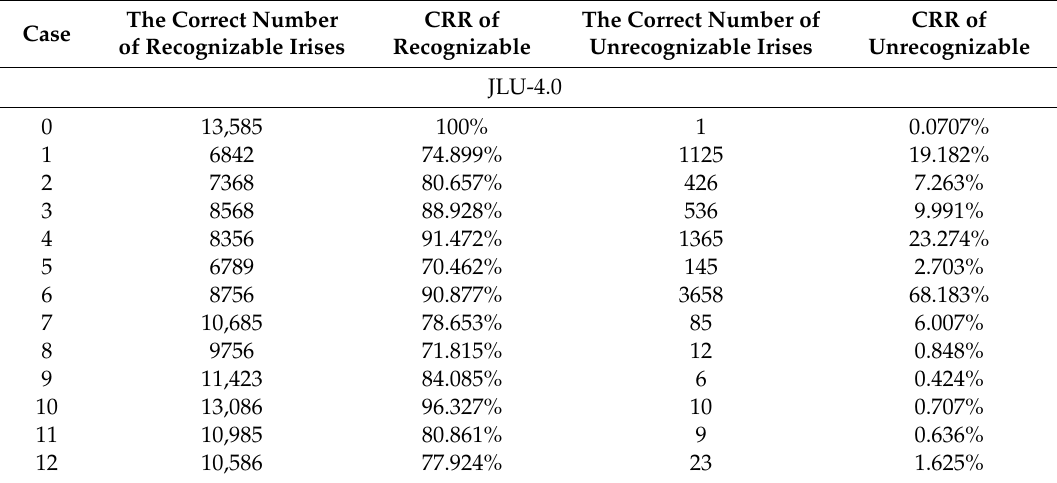
Table 21. The recognition results of all 12 cases in the three